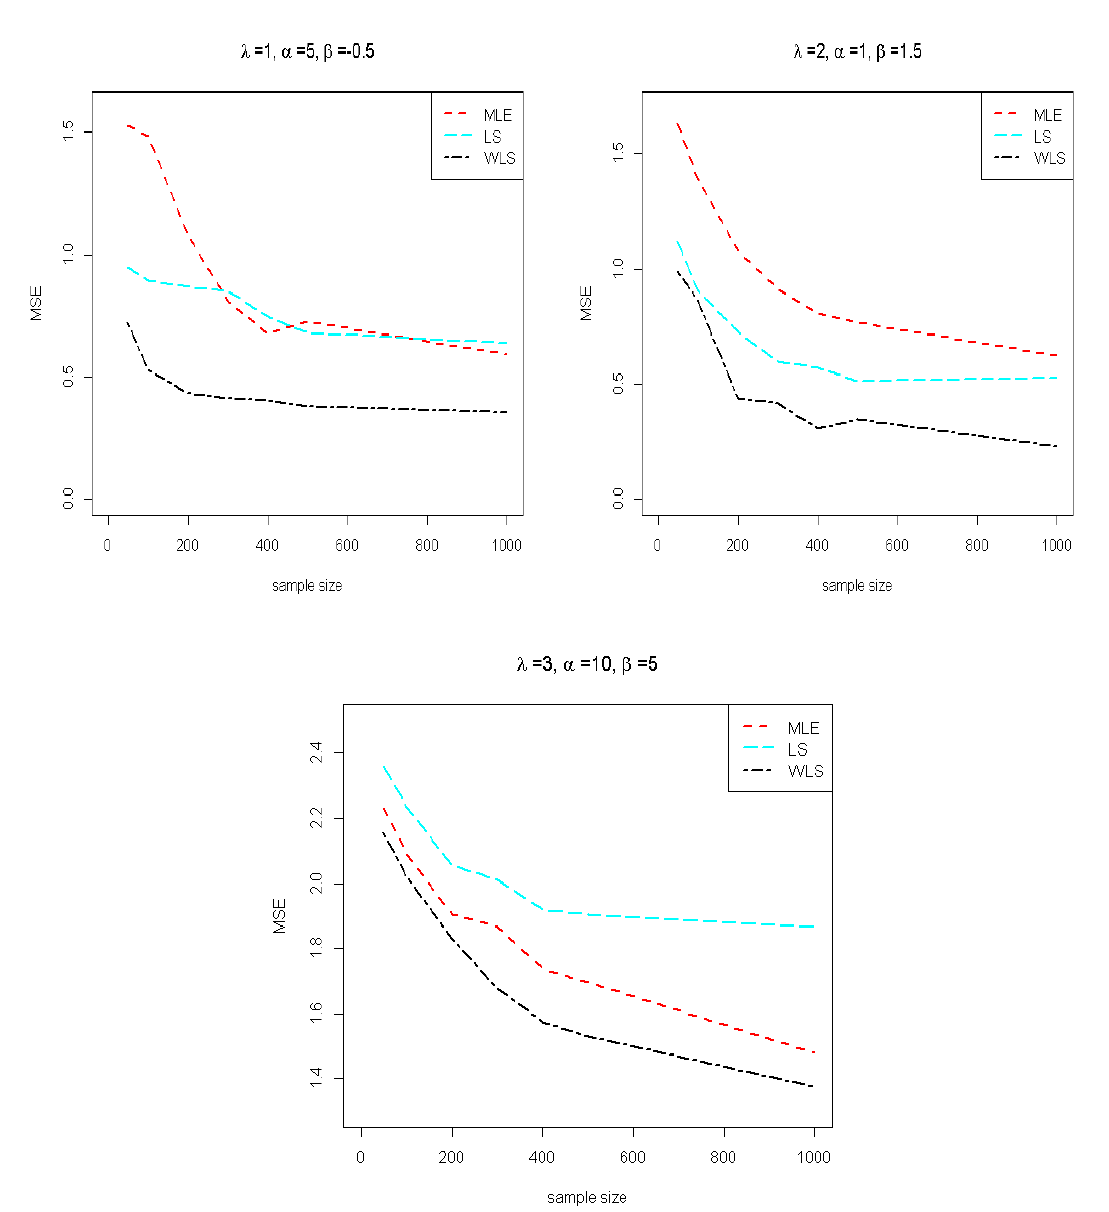
Figure 7. MSE of estimator ˆ θ versus sample size n for different